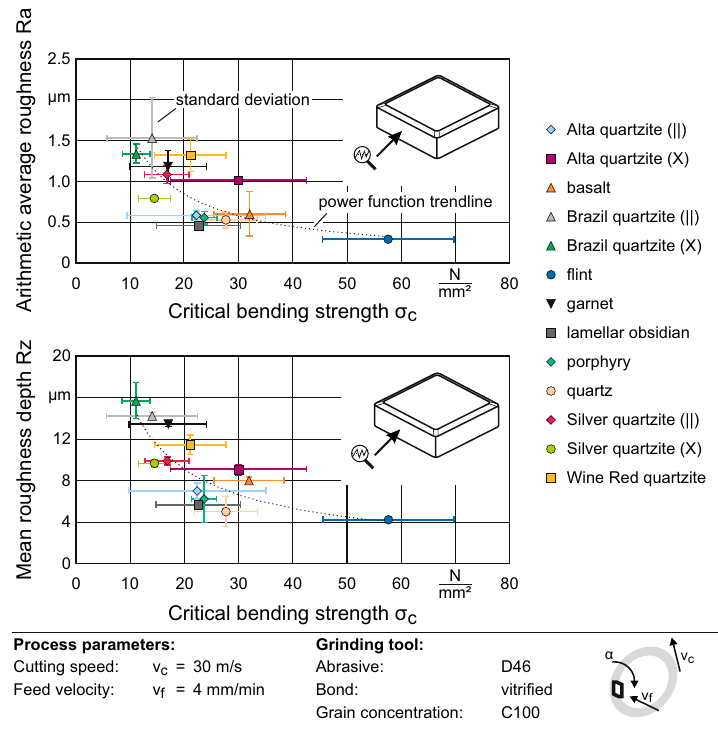
Fig. 13 Influence of critical bending strength on surface roughness at the flank